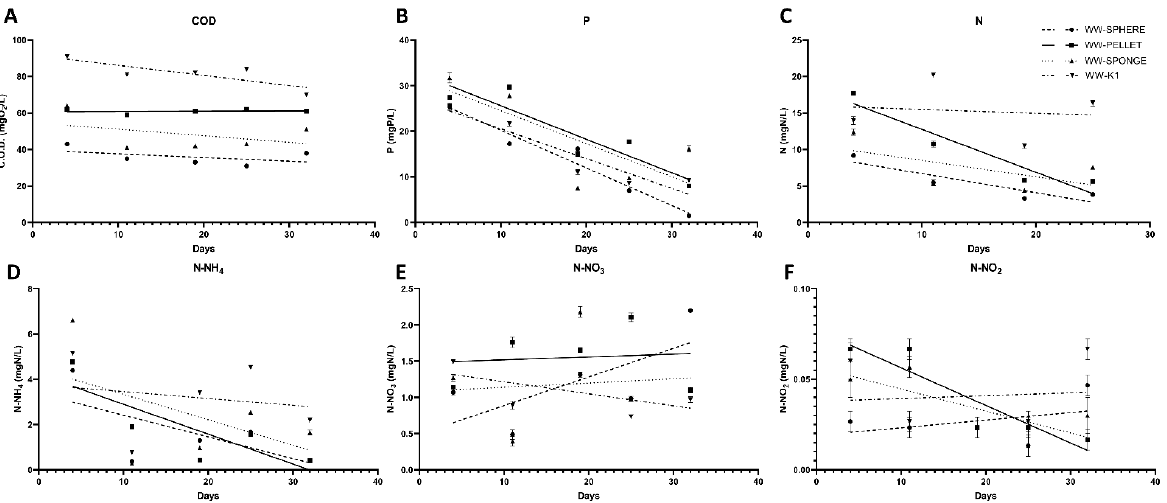
Figure 3. Variation of physicochemical parameters during WWT experiment using commercially available biocarriers. ( A ) COD, ( B ) P, ( C ) N, ( D ) N-NH 4 , ( E ) N-NO 3 , ( F ) N-NO 2 .